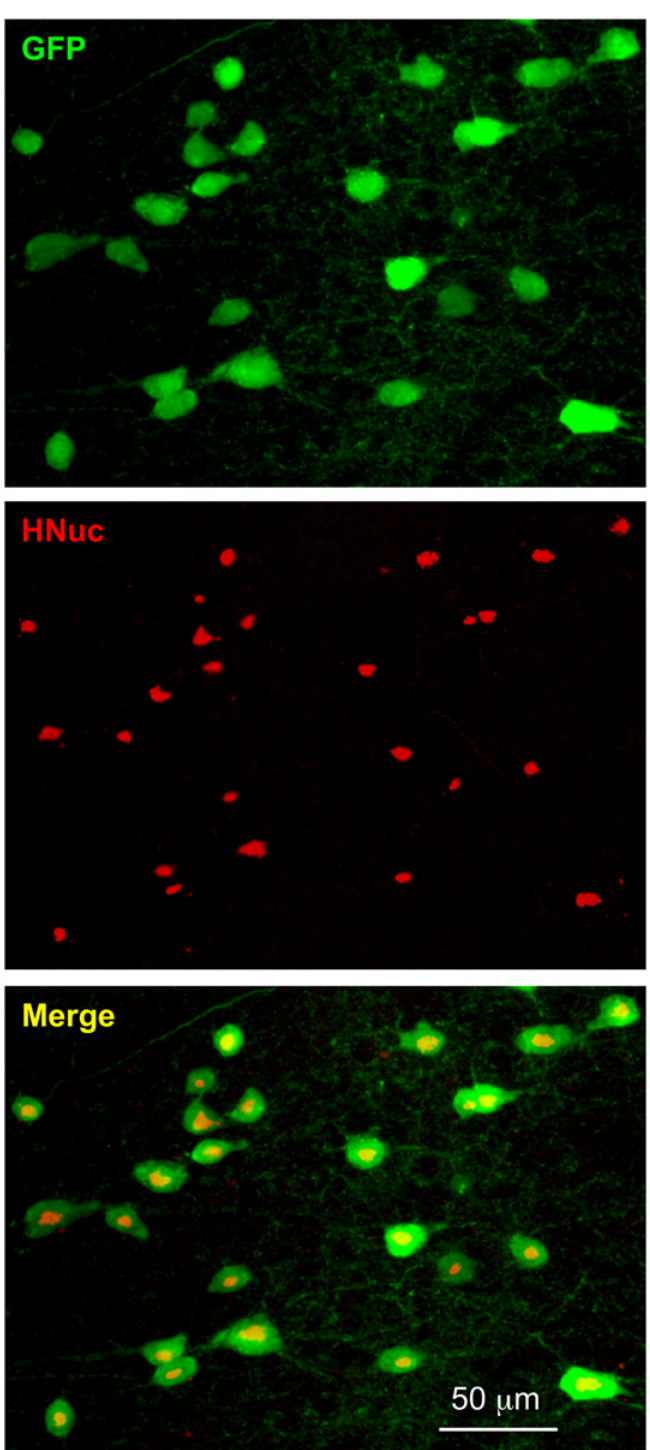
Fig 6. Immunoreactivity of hNPCs with an antibody against hNuc. All putative hNPCs (GFP+) were hNuc + cells at 8 W after transplantation (see merged image). No mouse cells were hNuc+.